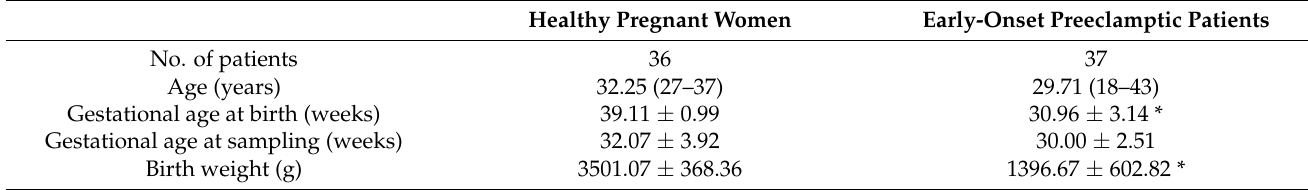
Table 1. Patients’ demographic and gynecological